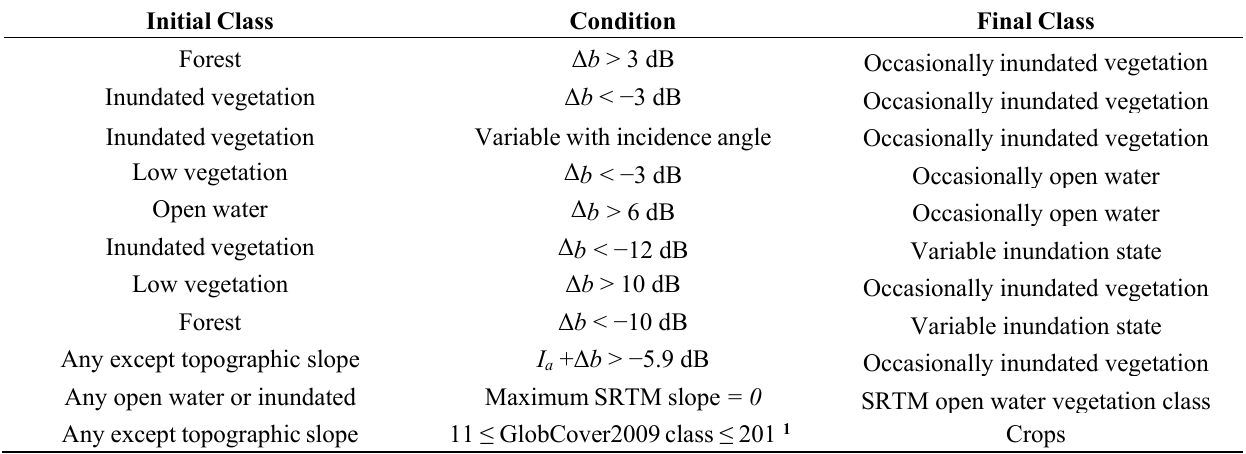
Table 2. Criteria for classification